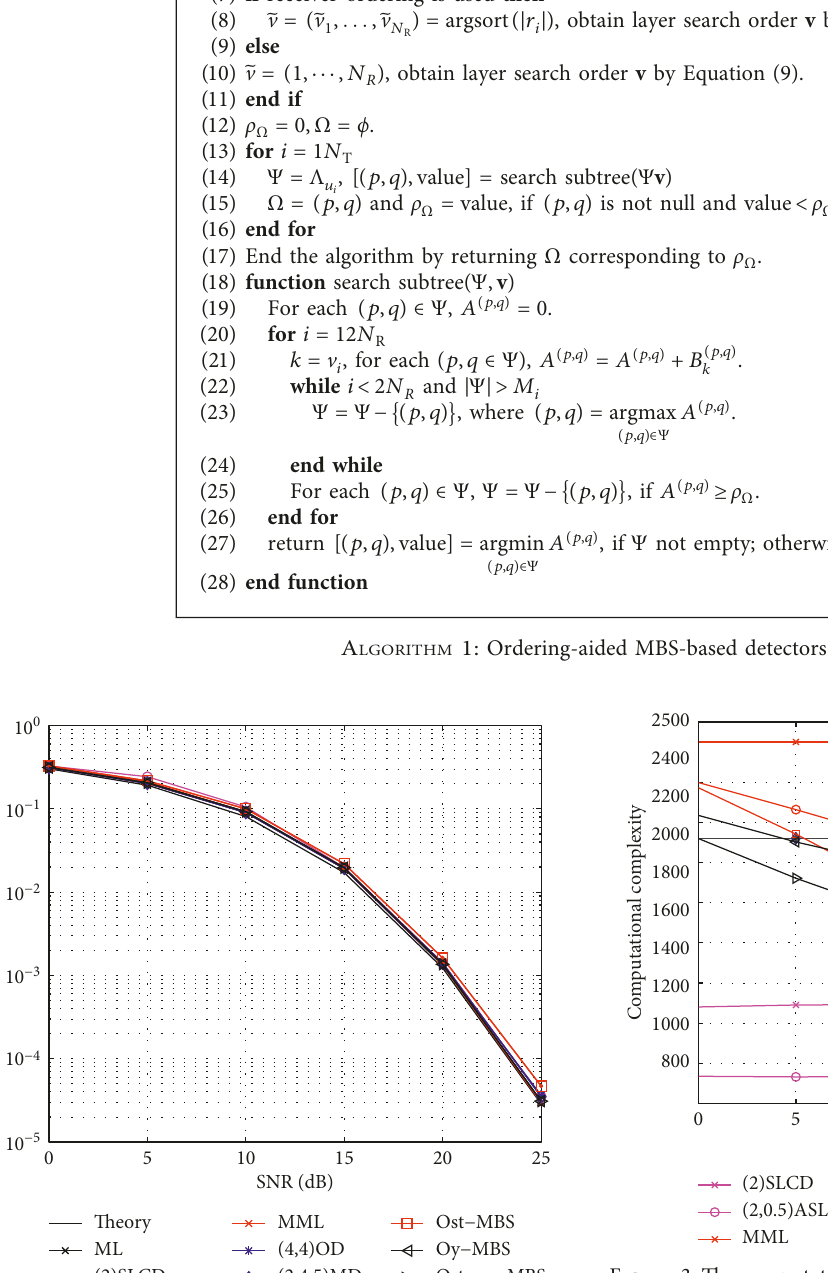
Figure 3: The computational complexity of the proposed detectors 4 , N R 4, and 64QAM with N T (cid:31) (cid:31) According to Section 3.5 and 3.6 in [17], the computational complexity of SLCD and ASLCD depends on the parameter N and the size of estimated transmit symbol set. Since the size of estimated transmit symbol set is not constant, the com- putational complexity can only be obtained by simulation.